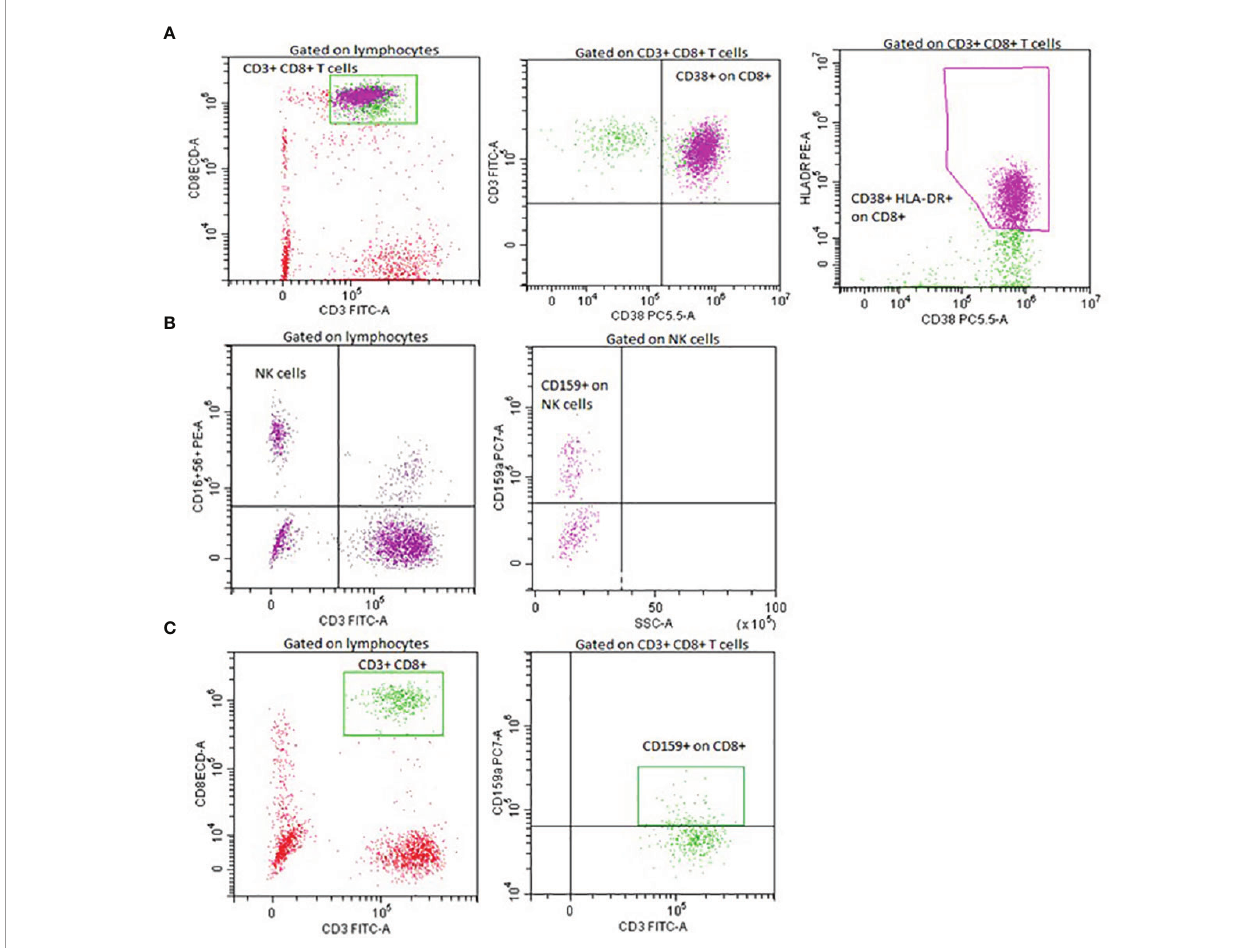
FIGURE 1 | Representative fl ow cytometry plots of lymphocyte activation and inhibitory markers expression. Expression of CD38 and HLA-DR on CD8 + cells (A) , expression of NKG2A/CD159 on NK cells (B) , expression of NKG2A/CD159 on CD8 + cells (C)